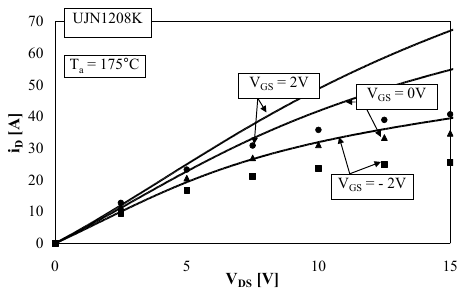
Fig. 2. Calculated and measured output characteristics of the transistor UJN1208K at 175°C .